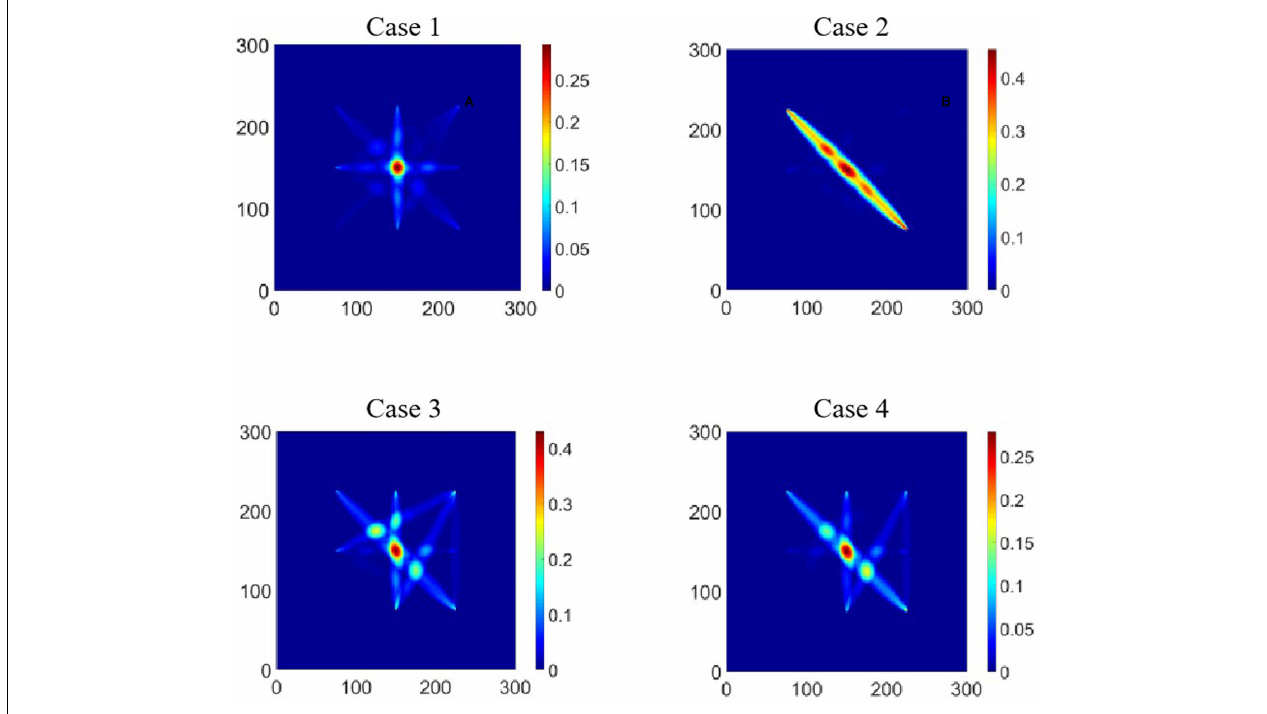
FIGURE 9 | Damage location based on guided wave damage diagnosis in Cases 1–4.